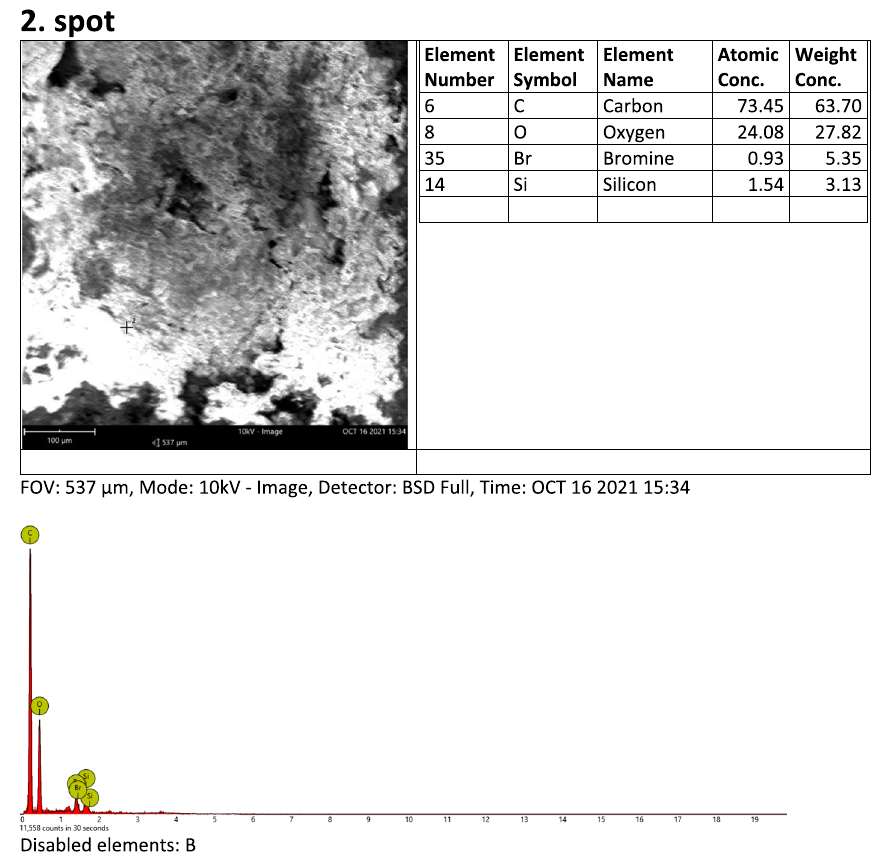
Fig. 6 Image 2 SEM-EDX for the friction lining material (FOV, 537 μm; mode, 10 kV—image, detector: BSD